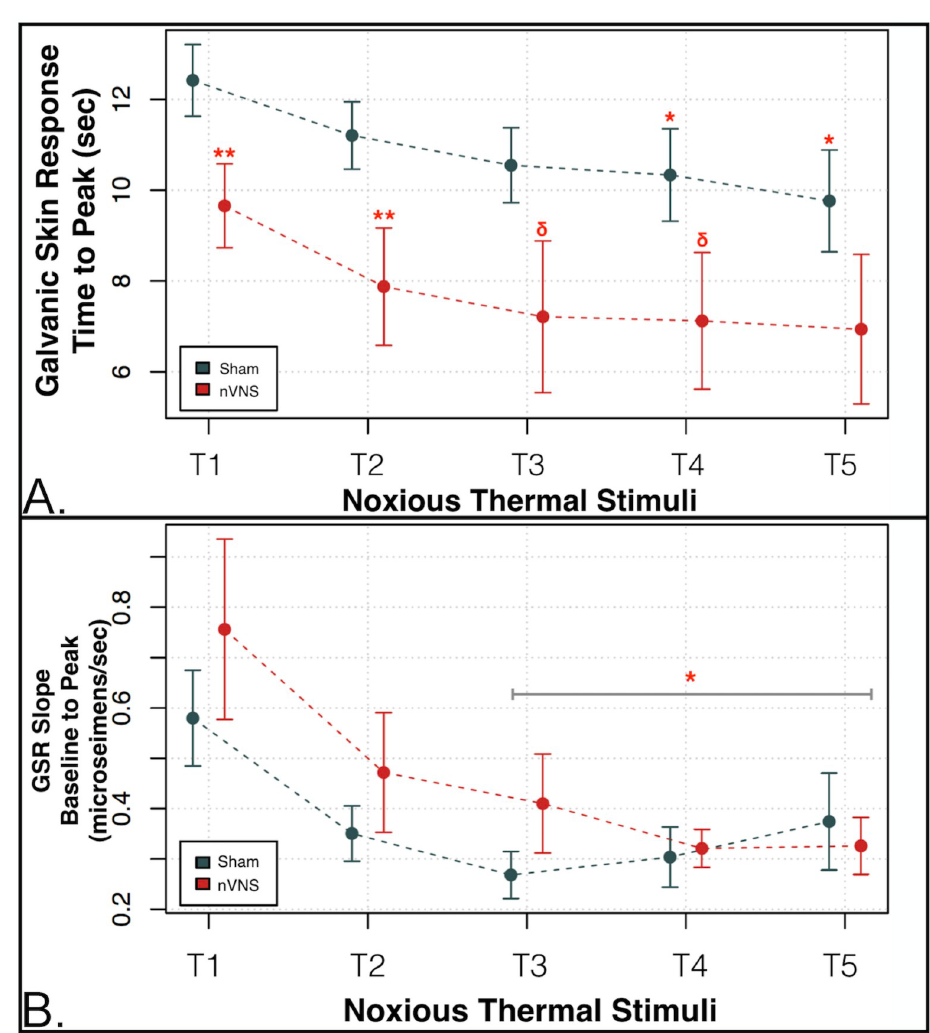
Fig 2. nVNS vs sham autonomic measures of sympathetic tone galvanic skin response (GSR) with noxious thermal challenge. (A) The time to peak galvanic skin response (GSR) measured in seconds after the application of each of the noxious thermal stimuli was significantly reduced in the nVNS group for noxious thermal stimuli 1 and 2 (T1 and T2) ( �� p < .05) compared with the sham group, and approached significance for T3 and T4 ( δ p < .09). Mixed- model regression showed that the combined (T1-T5) time to peak GSR in the nVNS group was significantly shorter compared with the sham group ( p < .02). (B) The GSR slope (in microsiemens) from the baseline GSR (prior to the application of each noxious thermal stimulus) to the peak GSR (accompanying each noxious thermal stimulus) was measured in each group. The slope from the baseline GSR to the peak response decreased in both groups with each successively applied noxious thermal stimulus from T1 to T3. However, whereas the nVNS group showed a negative average slope to peak GSR of -0.0461 from T3 to T5, the sham group showed a positive average slope to peak GSR of 0.049 from T3 to T5. The between-group difference (group x time interaction = -0.09508) for T3 to T5 was significant at � p < .05. Red circles = nVNS group. Blue circles = sham group.